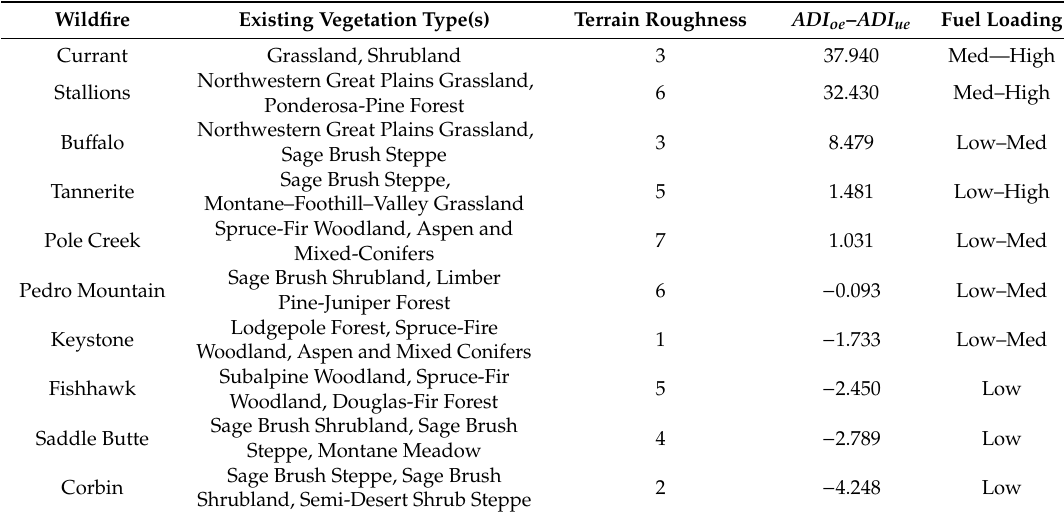
Figure 3. Maps of showing ignition polygon, fire perimeter (actual) and 18-h simulated fire perimeter for each of 10 fires modelled in this study. Table 3. Mean performance index values derived from all wildfire simulations based on the optimal Centroid Distance of five meters.